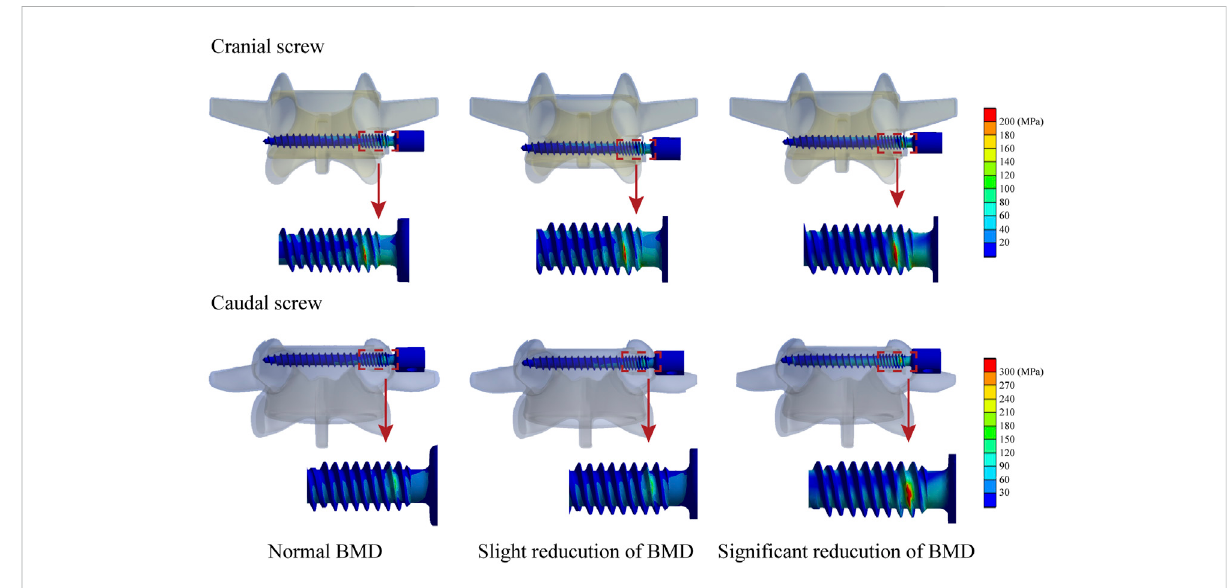
FIGURE 6 Nephograms for the maximum equivalent stress of screws under the right bending loading